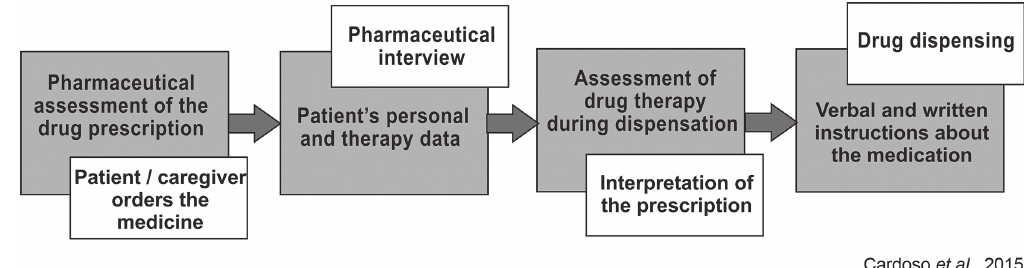
FIGURE 1 – Flowchart of drug dispensing processes routinely conducted at the University Pharmacy of the Federal University of